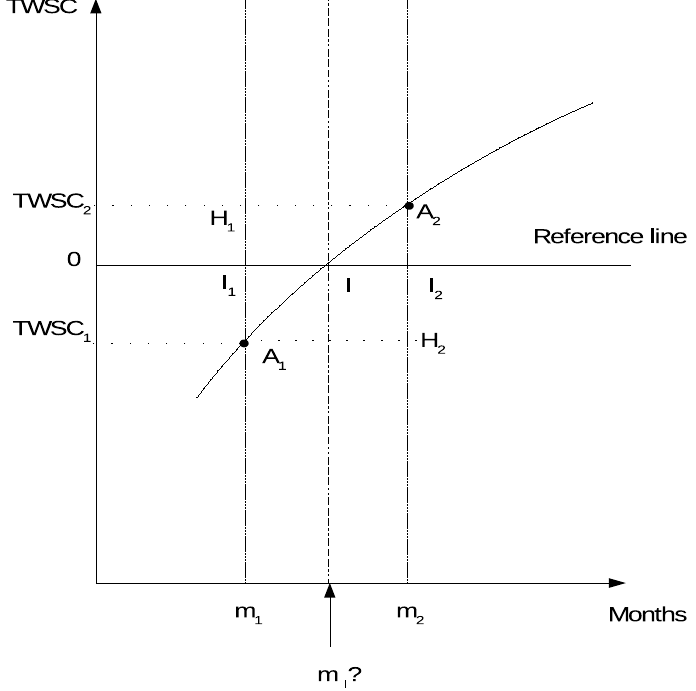
Figure 2. Illustration of the interpolation method used to deduce onset and retreat dates of the rainy season applying the TWSC